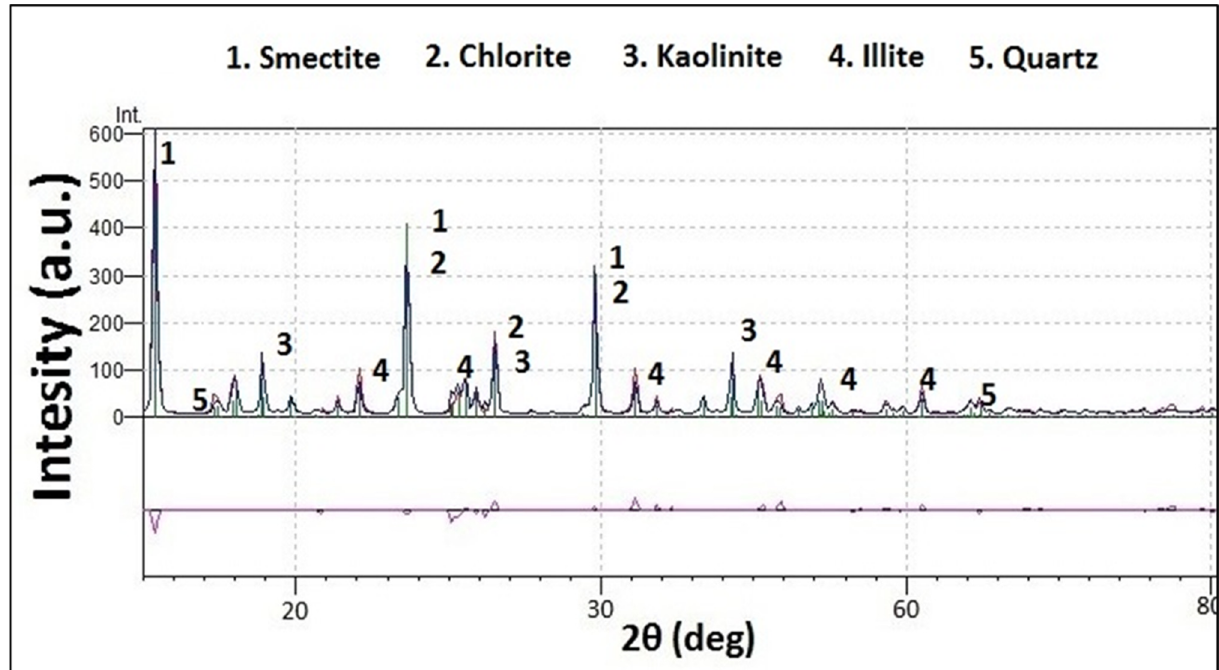
Figure 3. X-ray diffraction of Murree clay.